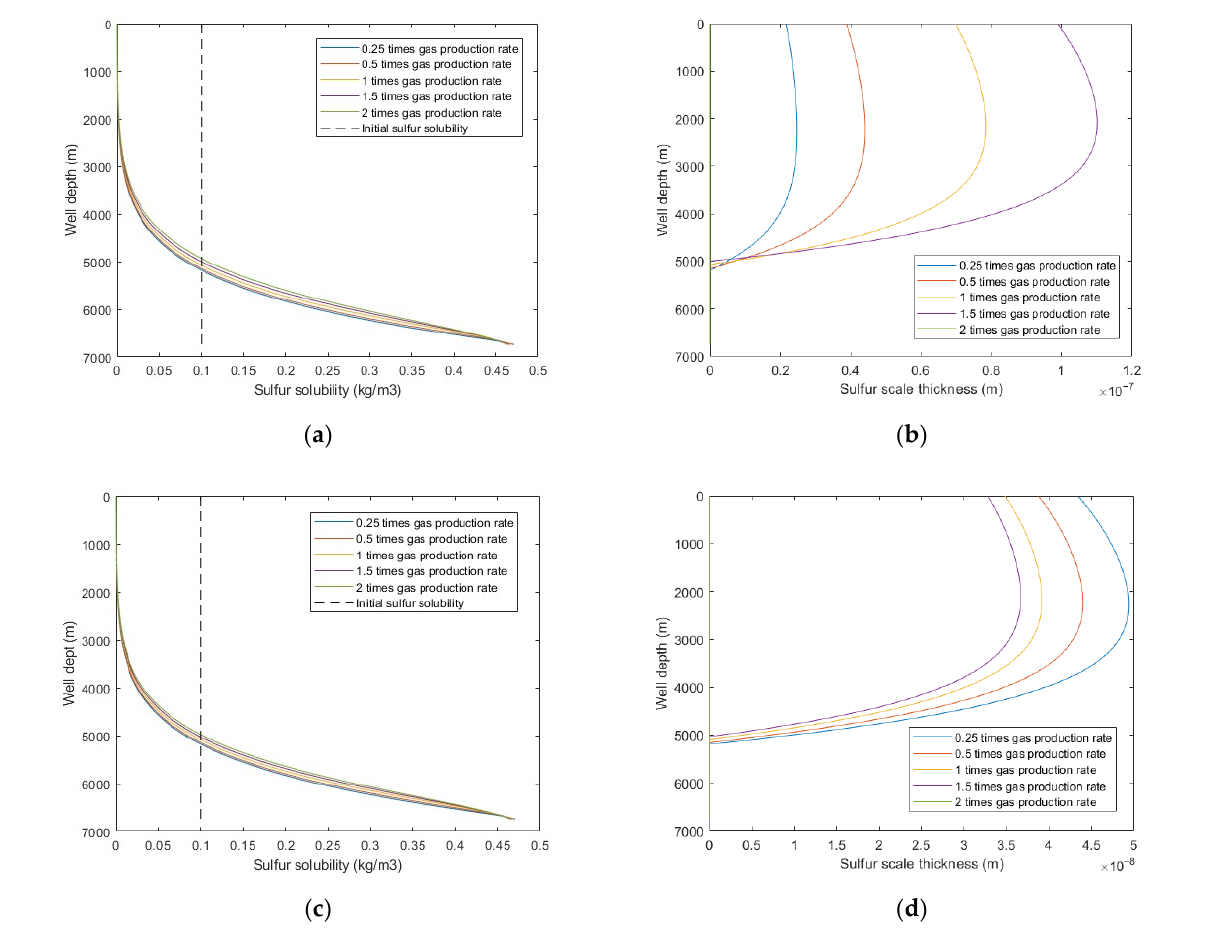
Figure 10. Calculated results with: ( a ) sulfur solubility distribution at different gas production rates (at same production time); ( b ) sulfur scale thickness distribution at different gas production rates (at same production time); ( c ) sulfur solubility distribution at different gas production rates (at same gas production quantity); ( d ) sulfur scale thickness distribution at different gas production rates (at same gas production quantity).